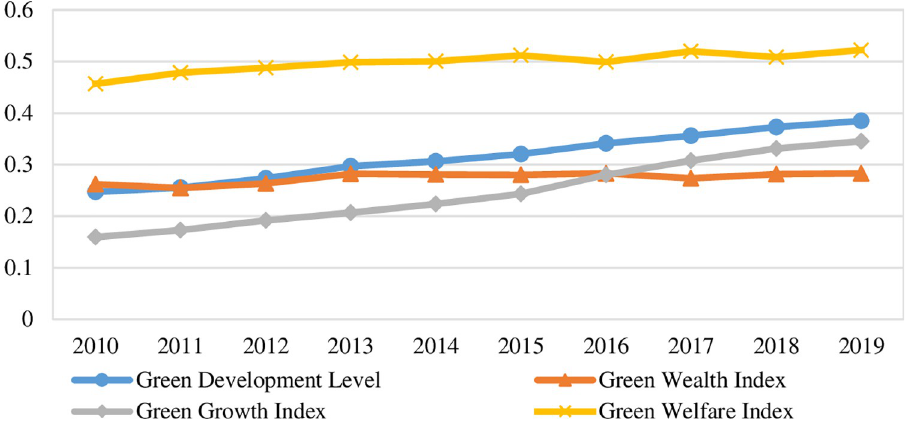
Fig 2. Trends of China’s green development level and its composition from 2010 to